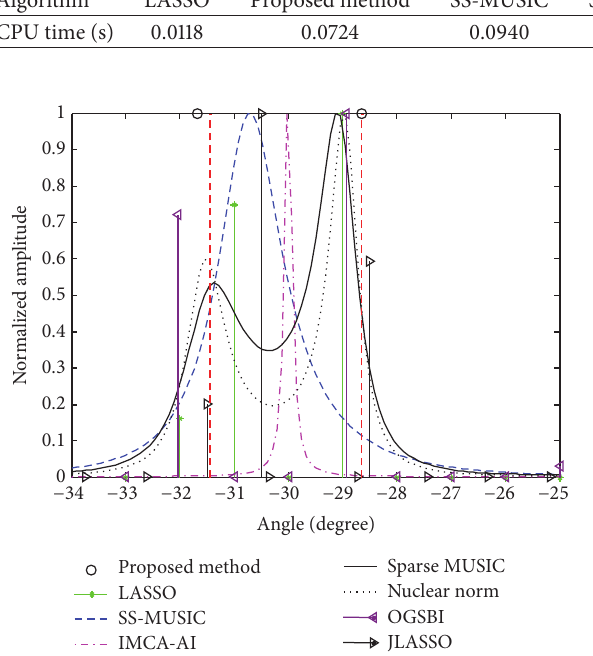
Figure 4: Resolution performance (SNR = − 10dB, 𝜆 𝑡 = 0.035 ).